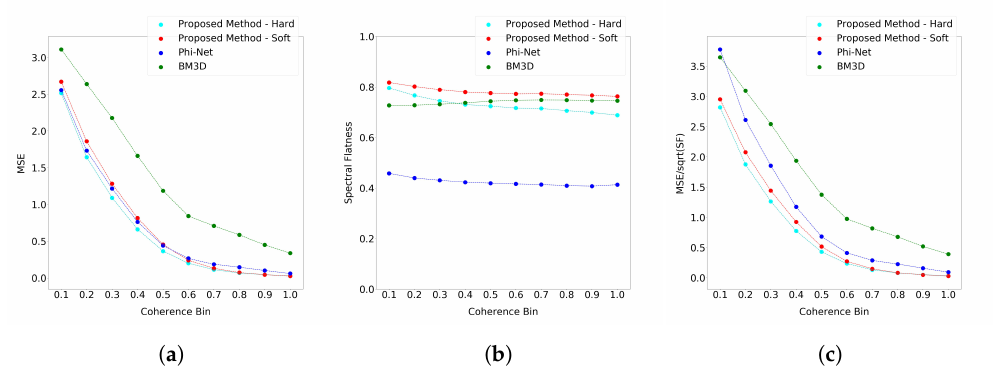
Figure 14. Medium-frequency case: mean square error ( a ), spectral flatness ( b ) and custom metric ( c ) for all methods under comparison.